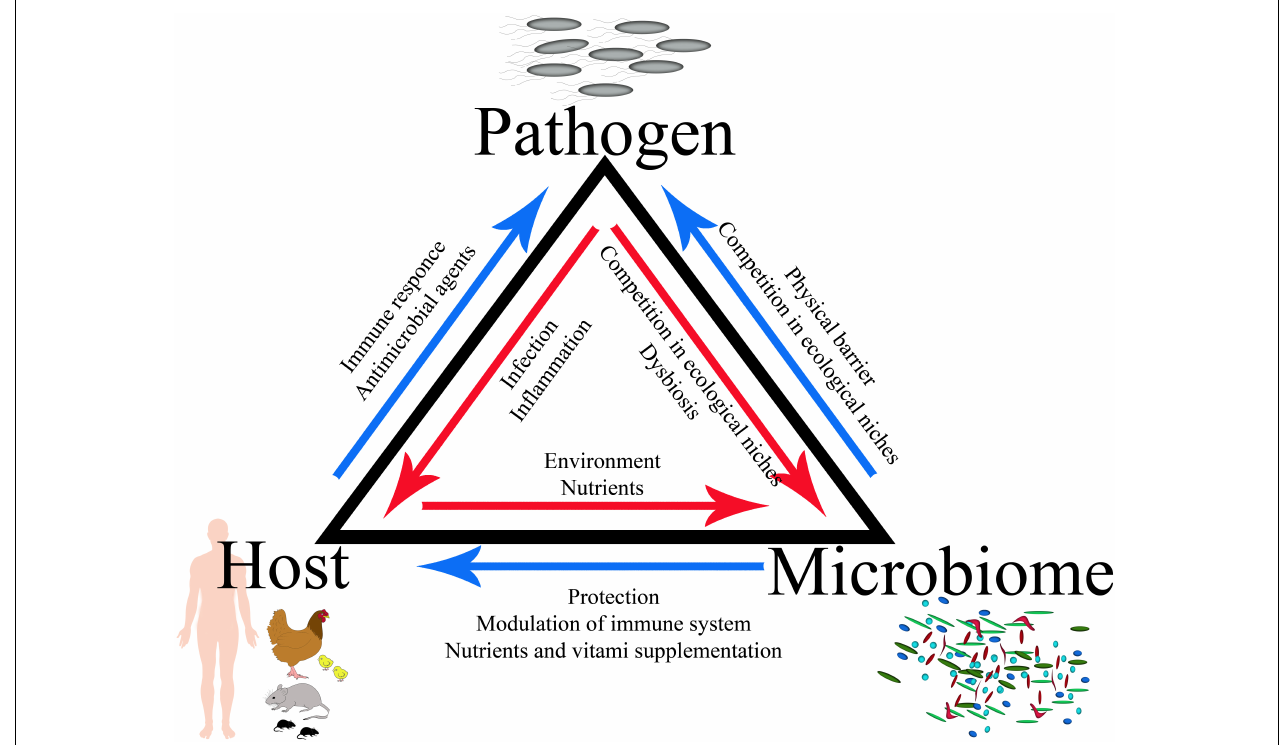
FIGURE 1 | Concept of the host–pathogen–microbiota